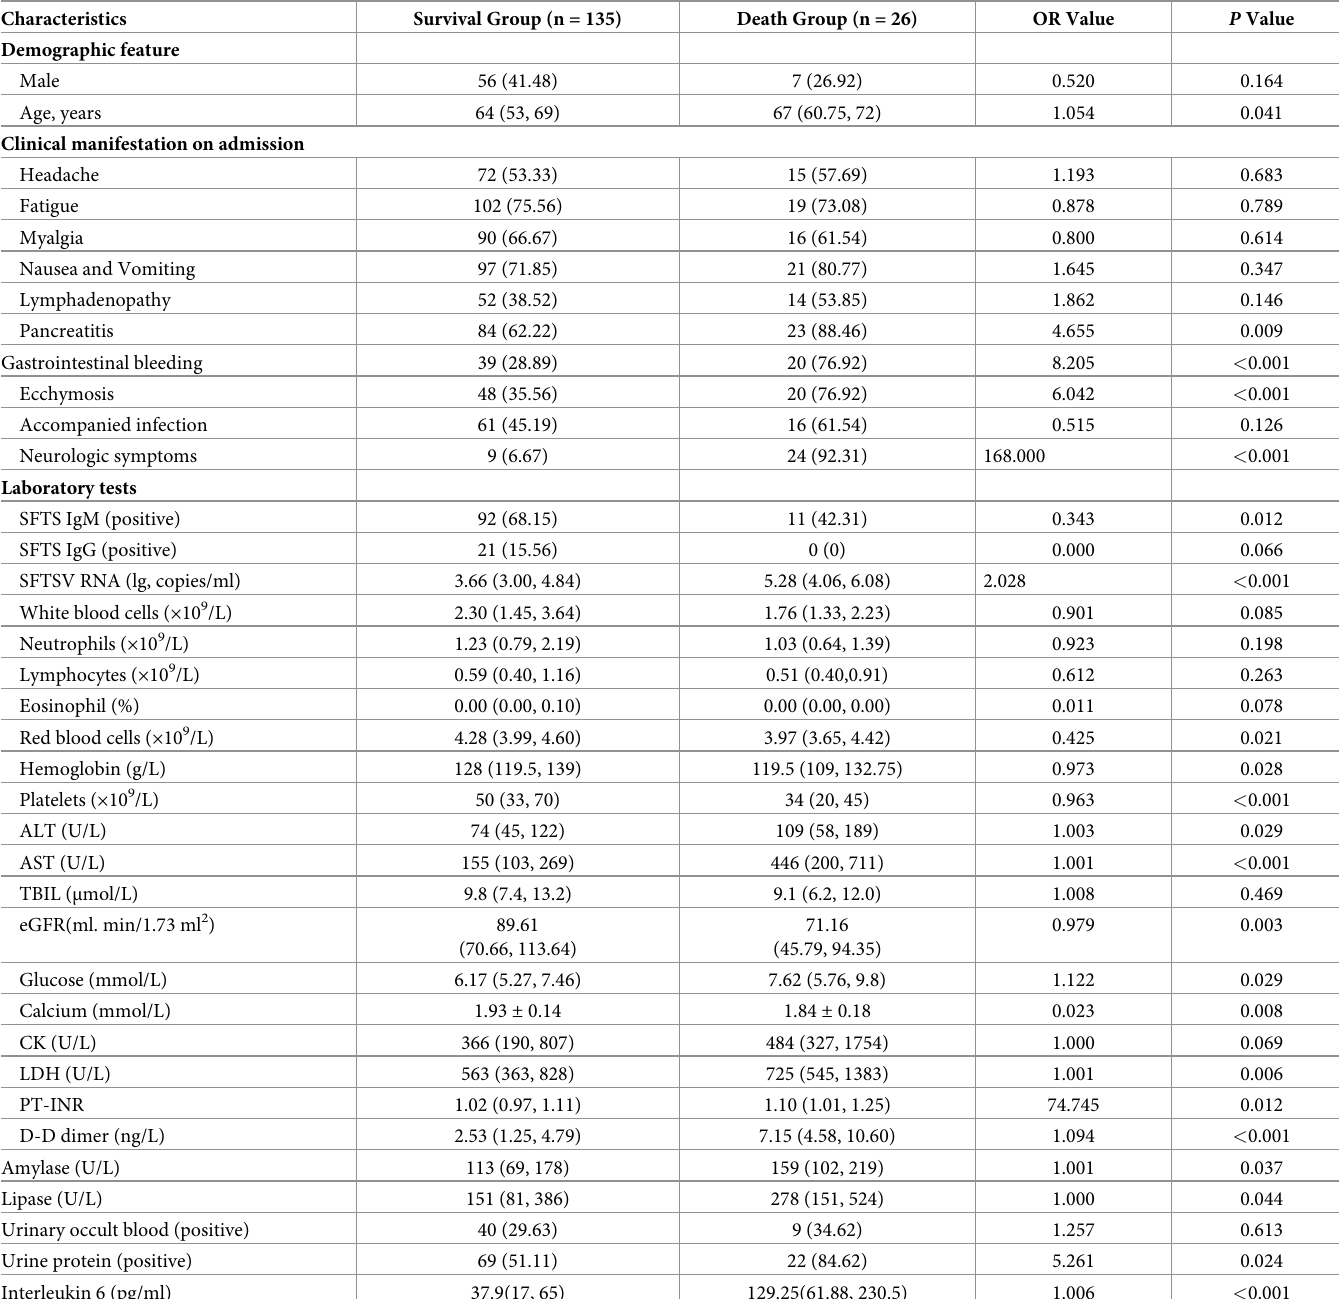
Table 1. Comparison of Clinical Features of Patients with SFTS in the Survival and Death Subgroups of the Modeling Group (% or Range).